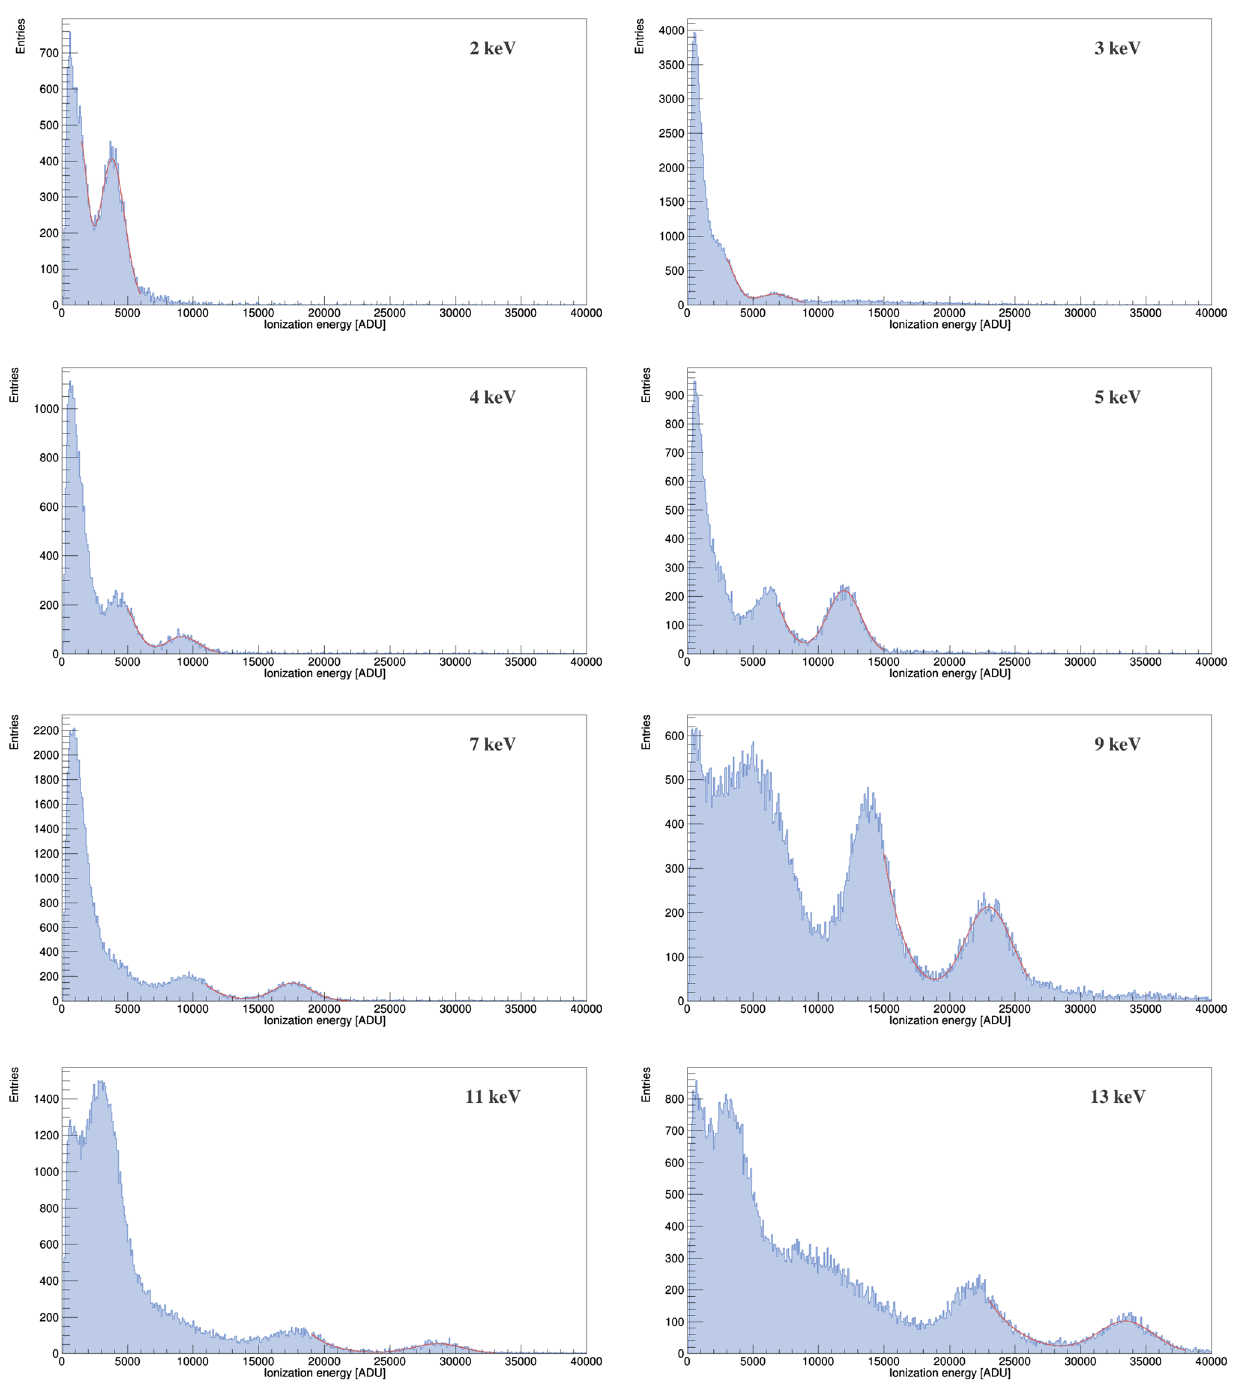
Fig. 7 Complete set of proton spectra measured at 1270 V. The fit functions of two Gaussian, used for the analysis, are shown in red. In each spectrum, the proton peak can be identified as the one with the highest ionization energy. The second peak from the right corresponds to